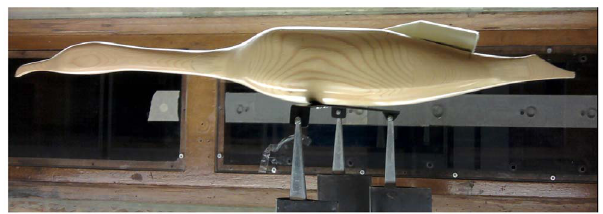
Figure 7. Photo of the suggested ideal placement for attaching tags on diving birds which also spend a significant amount of time flying. This is a bird model fitted with a dummy tag placed in a wind tunnel to measure the drag associated with various tag shapes and placements. The dummy tag shown on this picture is placed at the exact position for which the drag measured was minimum in air and water conditions (unpublished